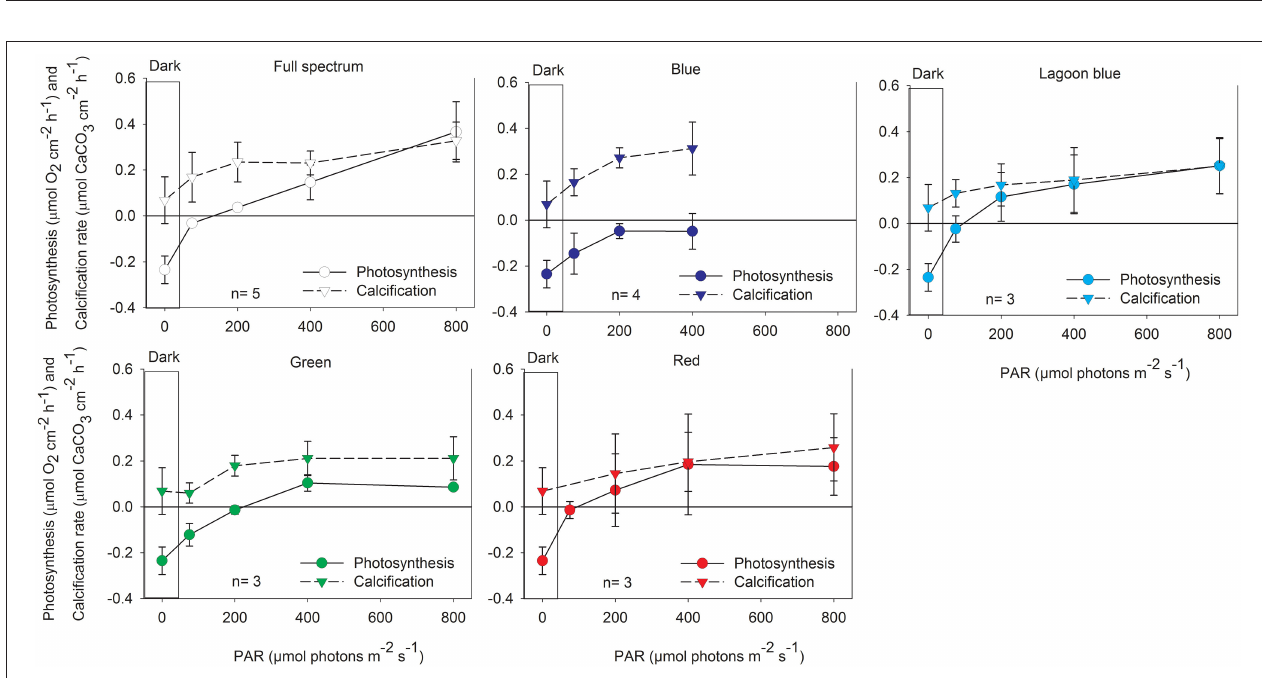
FIGURE 3 | Net photosynthesis and calcification (mean ± SD) of the coral P. lutea exposed to increasing intensities of control, full spectrum, blue, lagoon blue, green, or red light.